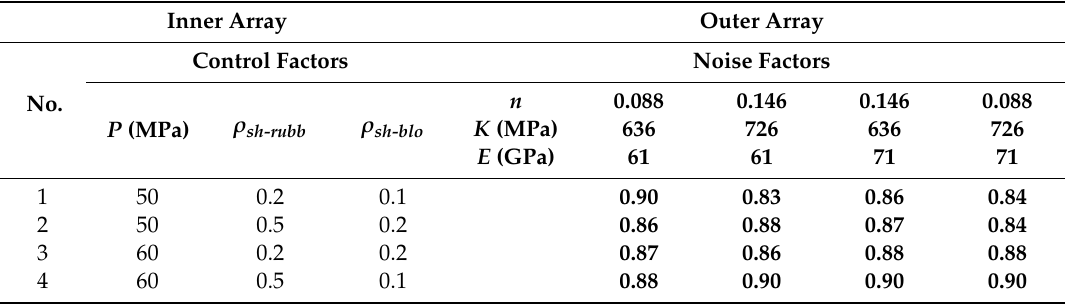
Table 4. Results of the minimum thicknesses t min (mm) obtained from the simulation by the FEM (the results are represented in the values in bold).